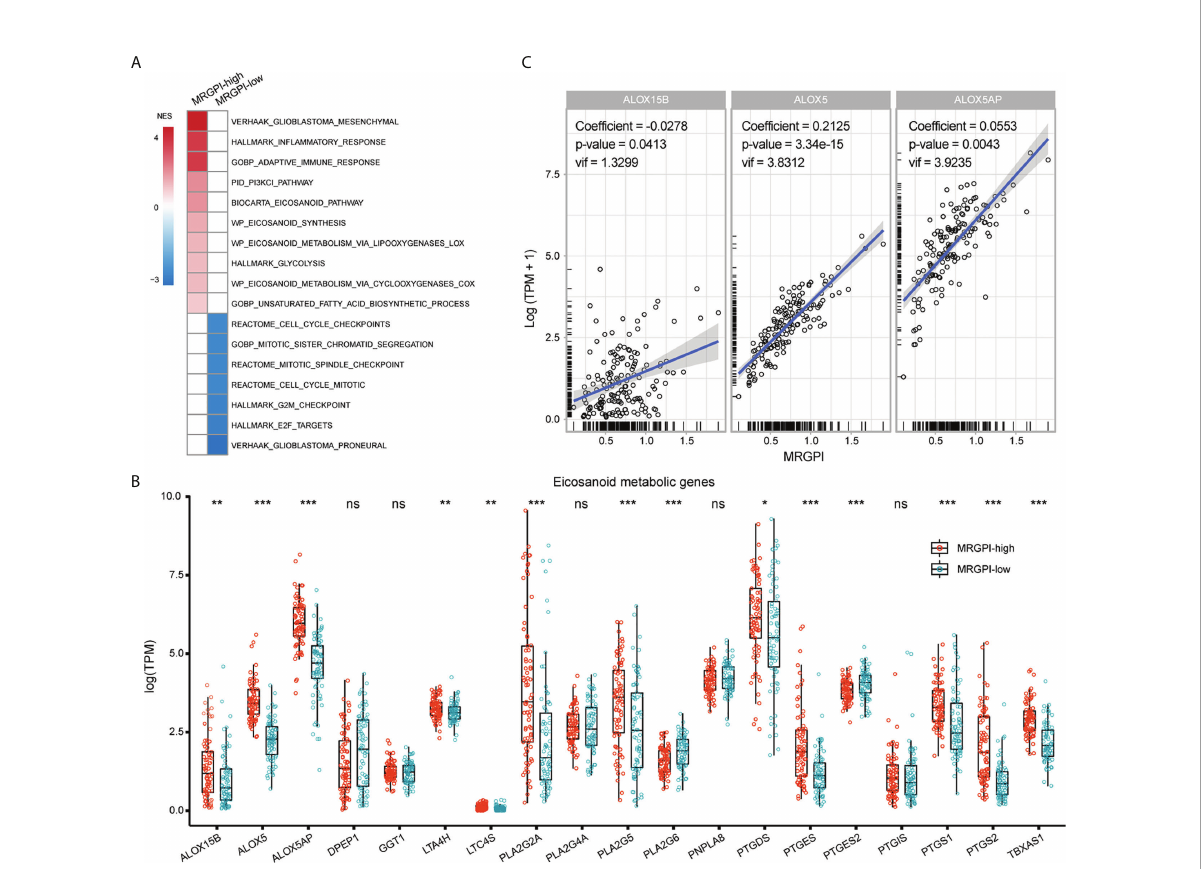
FIGURE 3 Molecular underpinnings associated with the MRGPI-based groups. (A) GSEA analysis of signaling pathways enriched in each group. Pathways of interest with FDR-q < 0.1 were exhibited. The color of the box was proportional to the NES. (B) The expression pattern of genes involved in the eicosanoid metabolic pathway between groups. (C) Multivariate Cox regression analysis of genes involved in the eicosanoid pathway for the estimation of their correlation with the MRGPI. *p < 0.05, **p < 0.01, ***p < 0.001. ns, non signi fi